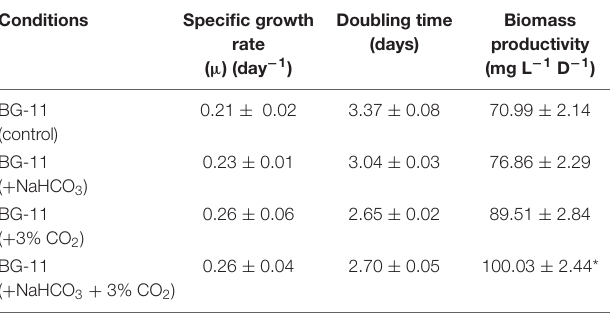
TABLE 1 | Growth parameters of Botryococcus braunii subjected to carbon